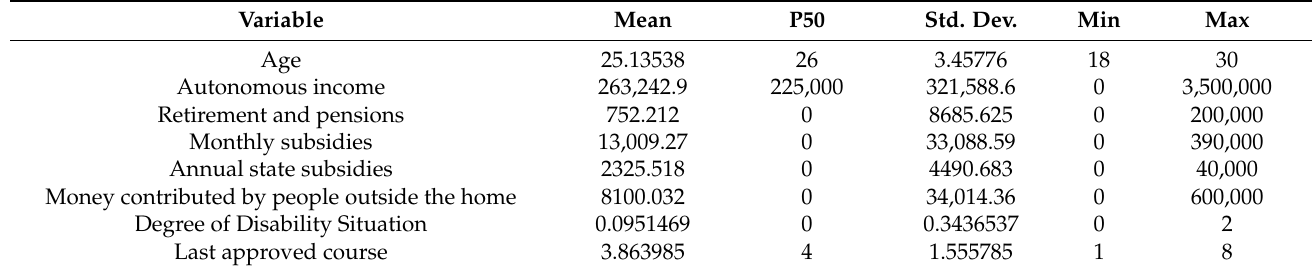
Table 1. Descriptive Statistics ( n = 1566).